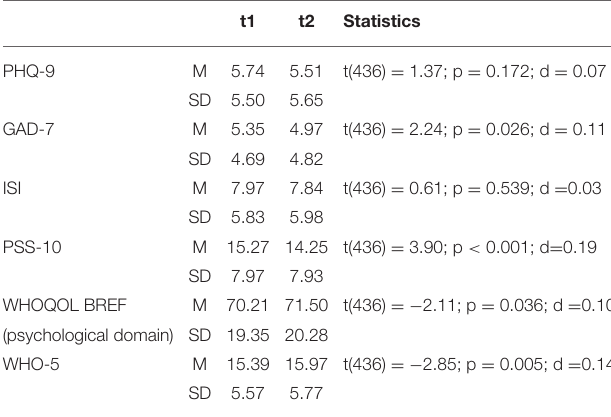
TABLE 2 | Measures of psychological health, well-being, perceived stress, depression, anxiety, and insomnia during the lockdown (t1) as compared to 6 months after the initiation of the lockdown (t2) in n = 437